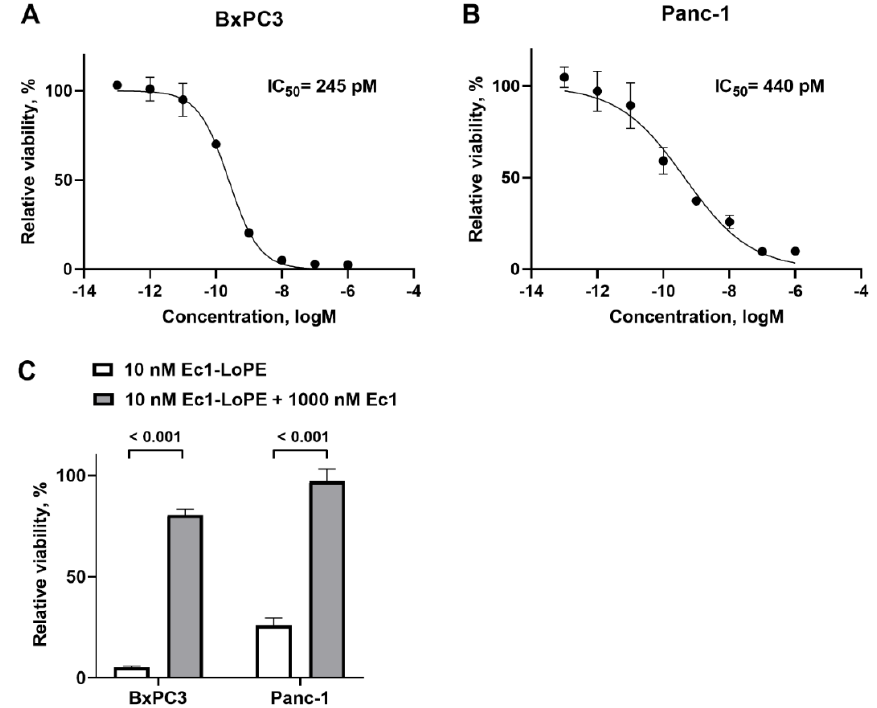
Figure 3. The cytotoxic effect of Ec1–LoPE in EpCAM-expressing ( A ) BxPC3 and ( B ) Panc-1 cells in vitro. ( C ) Specificity of Ec1–LoPE action in BxPC3 and Panc-1 cells. The viability of cells grown in medium (no Ec1–LoPE added) was used as 100% viability control. Relative viability (the y -axis) was plotted versus concentrations of Ec1–LoPE (the x -axis) to derive the viability curve. The data are presented as average ± SD of five samples.